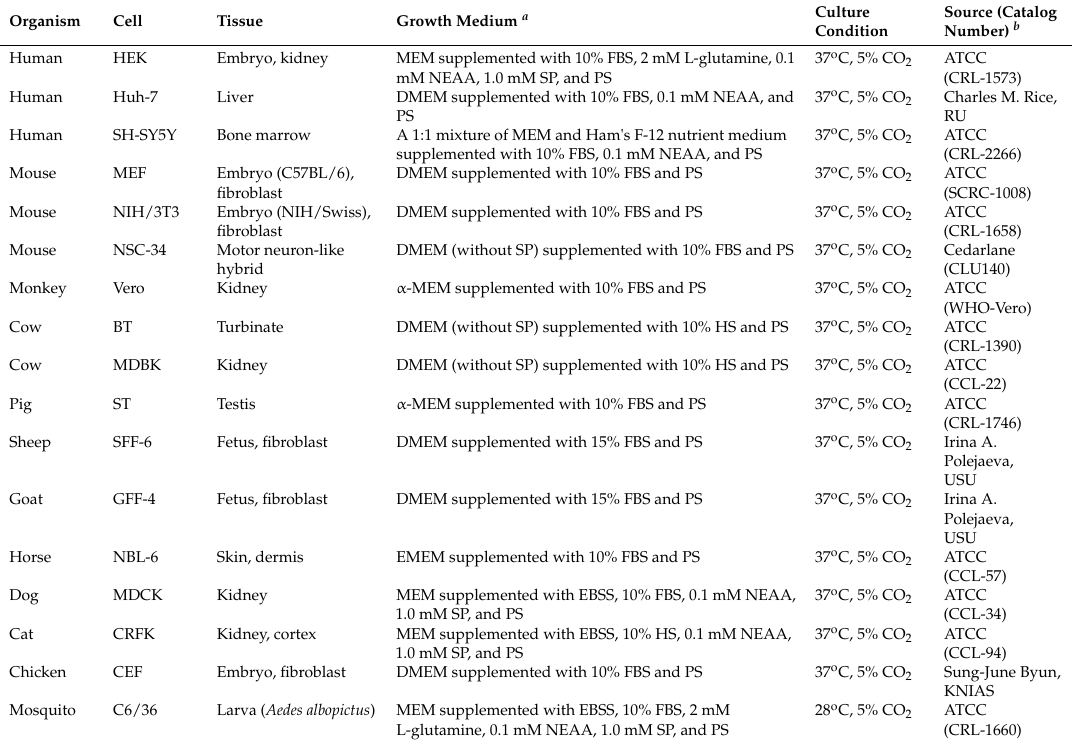
Table 1. Cells used in this